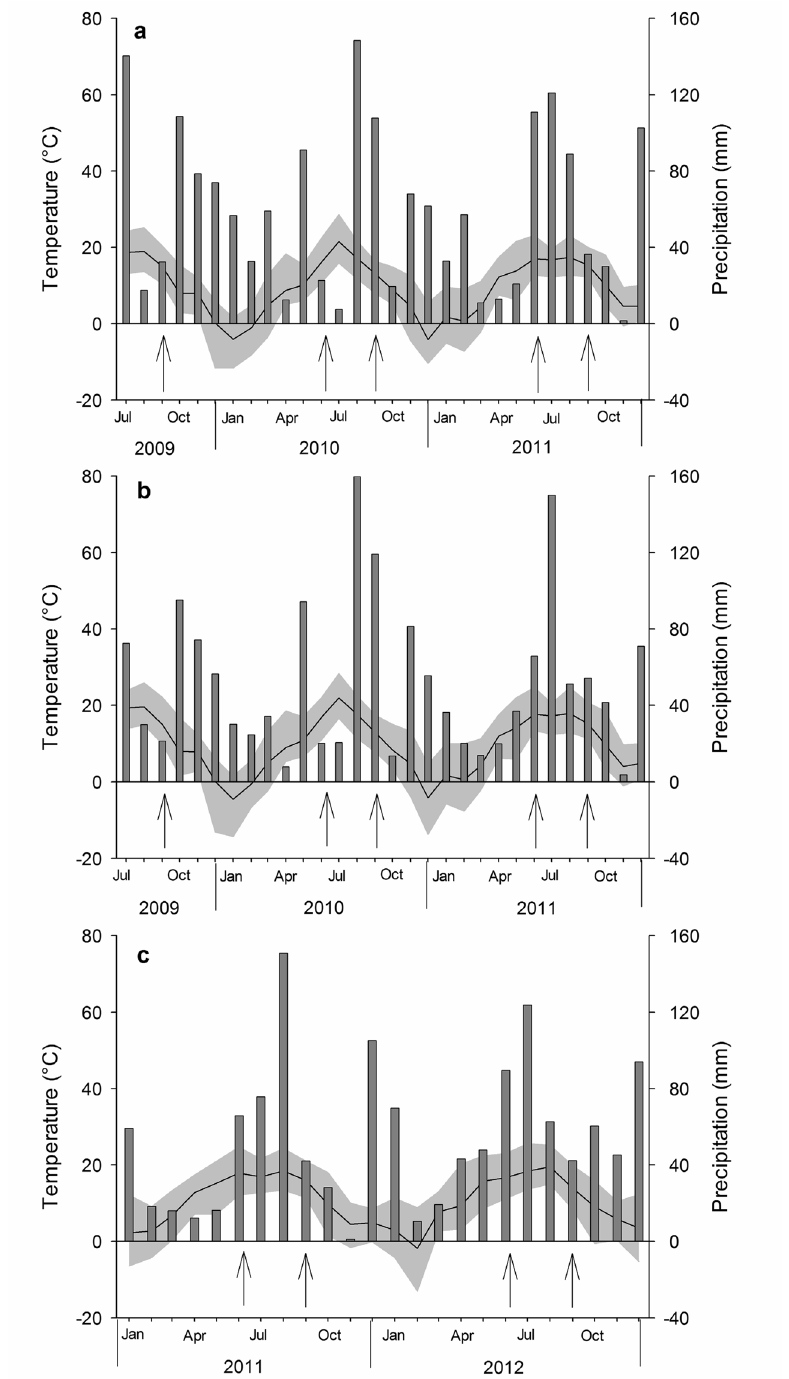
Fig 1. Weather conditions at the Elbe tributaries Sude (a) and Havel (b) during the study years 2009 to 2011 and at the Rhine (c) during the study years 2011 and 2012 (data provided by the DWD 2013). The black line with grey shade represents daily average, minimal and maximal monthly temperatures. The grey bars are monthly sums of precipitation. Arrows indicate the dates of biomass sampling.